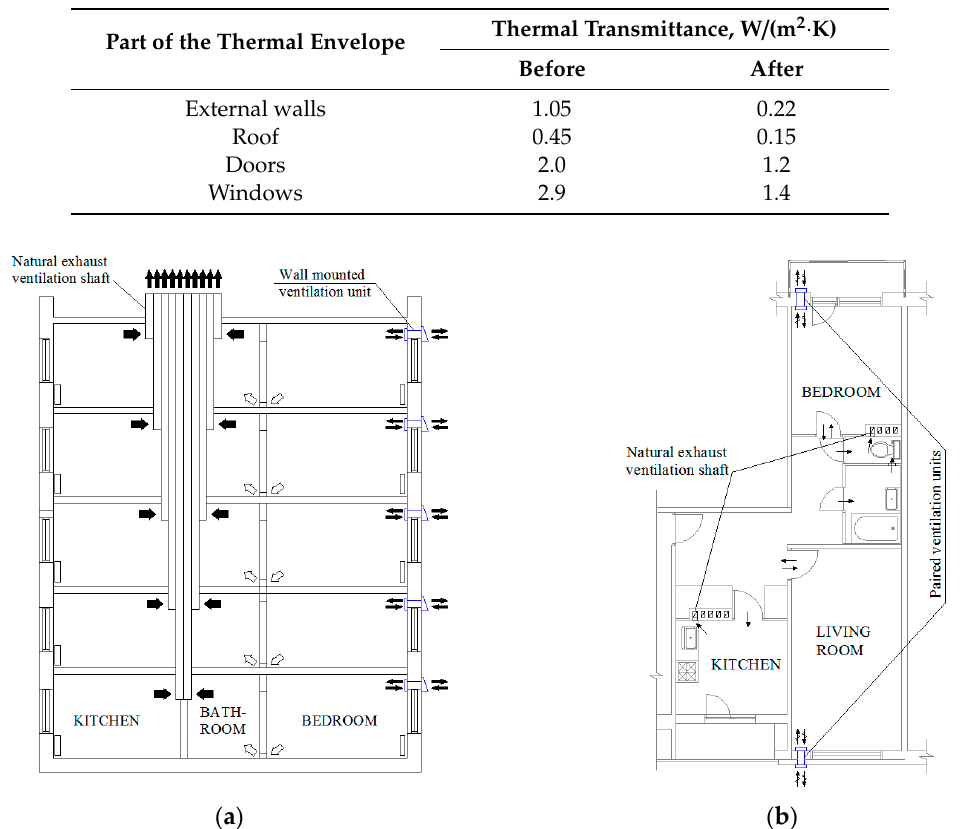
Figure 4. Principle solution of the ventilation system with room-based units: ( a ) cross-section and ( b ) floor plan of a typical apartment. Table 1. Thermal transmittances of the envelope before and after retrofitting.